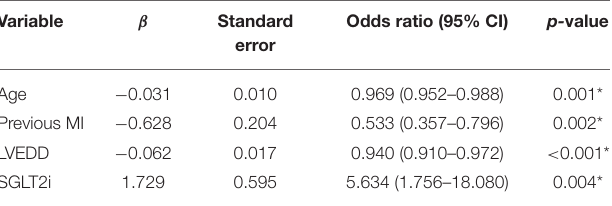
TABLE 2 | Multivariate analysis of HFiEF after 1